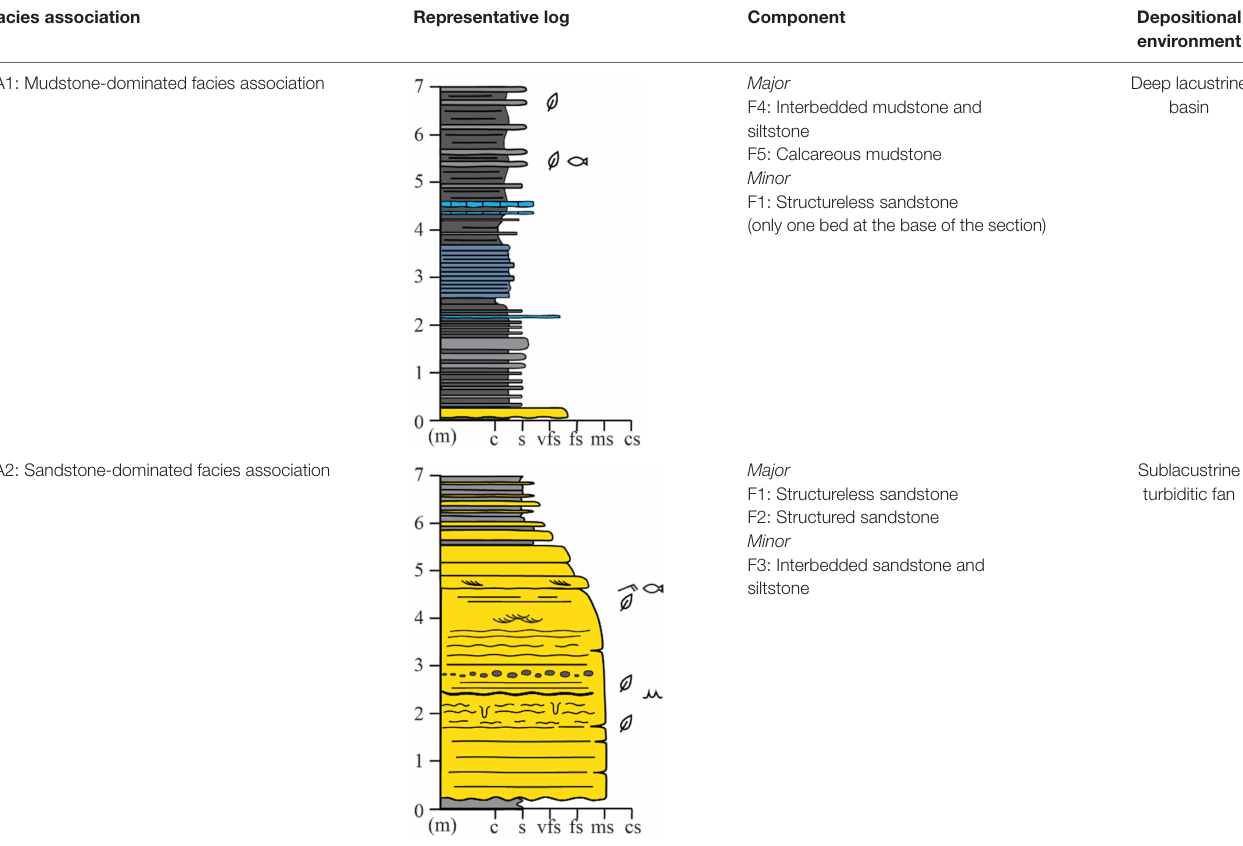
TABLE 2 | Facies associations and representative logs.